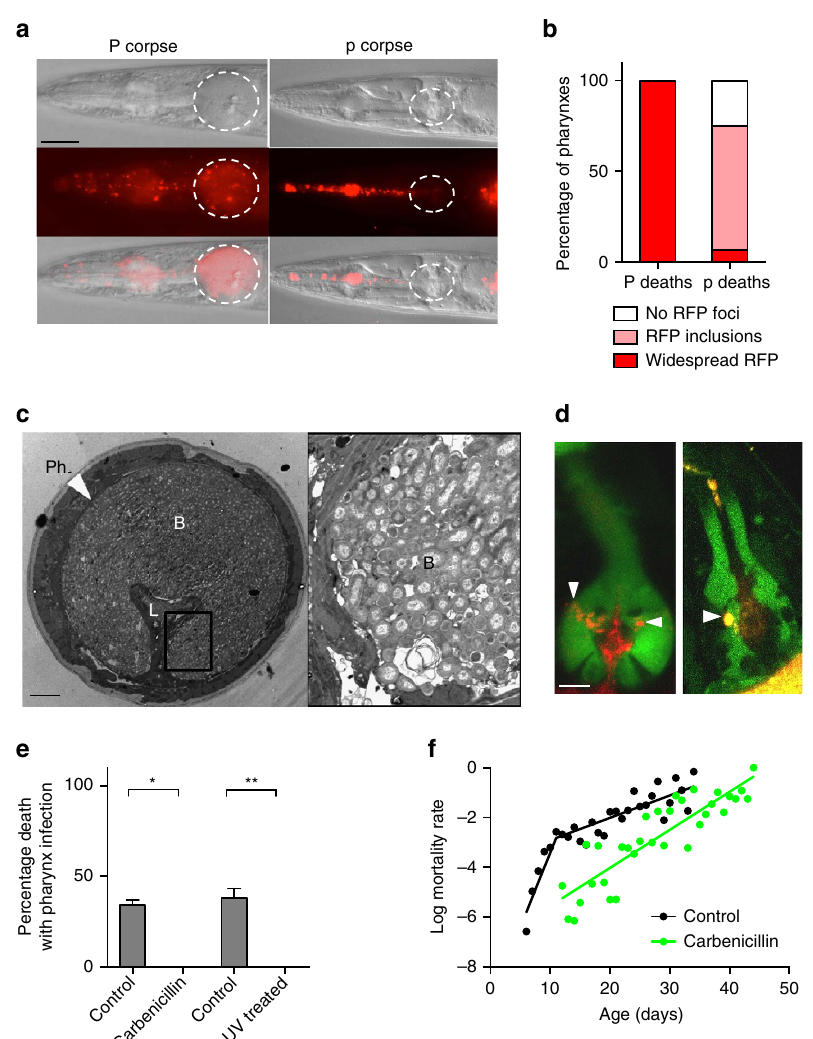
Figure 2 | Swelling in P deaths results from E. coli infection. ( a ) Comparison of P and p corpses of worms fed with E. coli expressing RFP. Scale bar, 40 m m. ( b ) Proportion of P ( n ¼ 70) and p ( n ¼ 75) corpses with widespread RFP, small intra-pharyngeal RFP inclusions or no detectable RFP foci. (Trials: 2). ( c ) Representative TEM of a swollen pharynx from a live, 8-day-old adult. L, lumen; Ph, pharynx; B, bacteria. The elongated appearance of some bacilli suggests that proliferation occurs within pharyngeal tissue. For TEMs of pharynxes at different stages of infection, see Supplementary Fig. 5. Scale